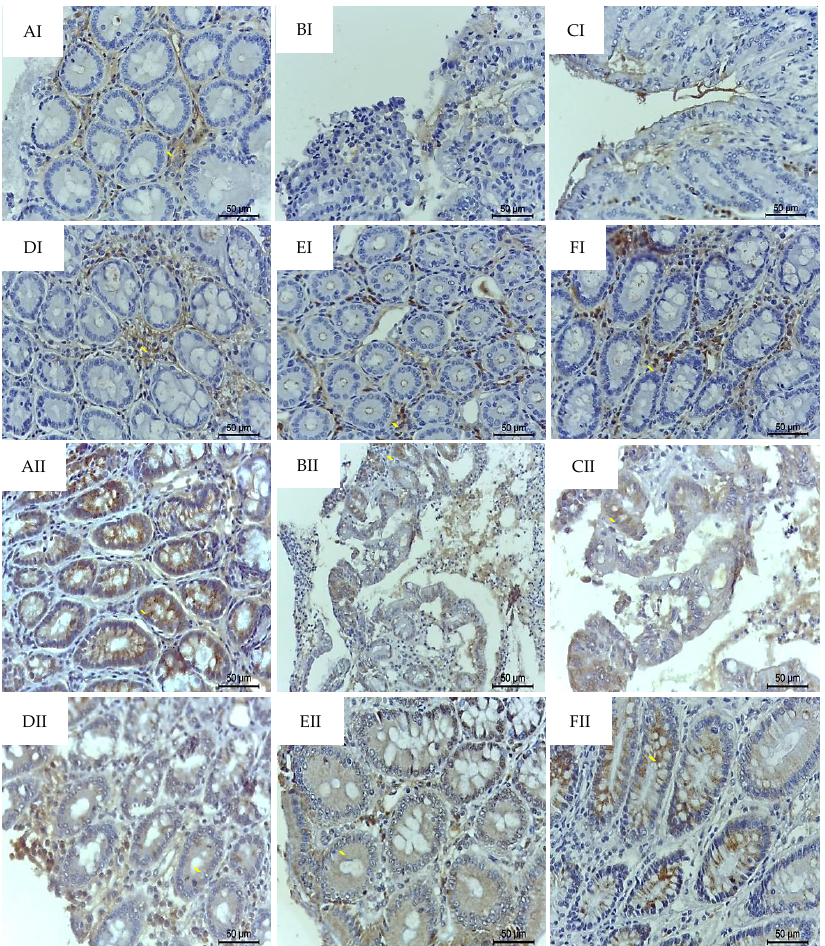
Figure 6. Photomicrographs with immunohistochemical staining ( → ) for MUC-2 ( I ) and ZO-1 ( II ) in colon samples from rats submitted to TNBS-induced ulcerative colitis. ( A ) Non-colitic; ( B ) colitic (5% Tween 80); ( C ) colitic (0.9% NaCl); ( D ) prednisolone (2 mg/kg); ( E ) p- C (200 mg/kg); ( F ) RA (200 mg/kg). Scale: 50 μm. 400×. MUC: mucin; ZO: zonula occludens.